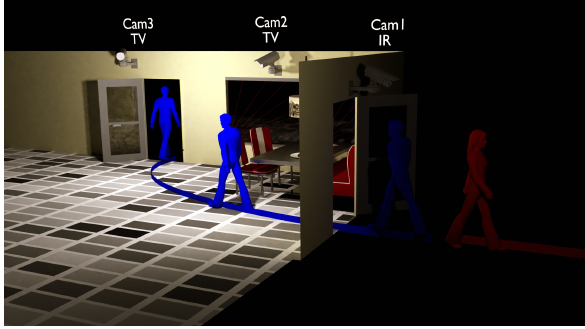
Figure 1. A typical ReID